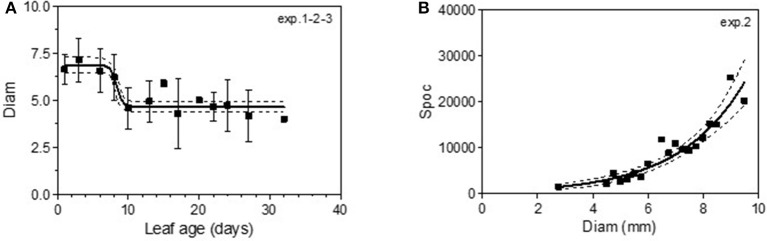
Colony diameter in mm (Diam) as a function of leaf age after 14 days of colony growth (A) and number of spores produced per colony (Spoc) as a function of the colony diameter (B) for Cabernet-Sauvignon. (A) correspond to the average colony diameter from experiments 1–3 whereas Panel (B) to the spores per colony from experiment 2. Plain lines correspond to the fitted models M2 (A) and M4 (B) in Table 4. Dashed lines correspond to the 95% confidence bands on the models, and bars correspond to the standard deviation.